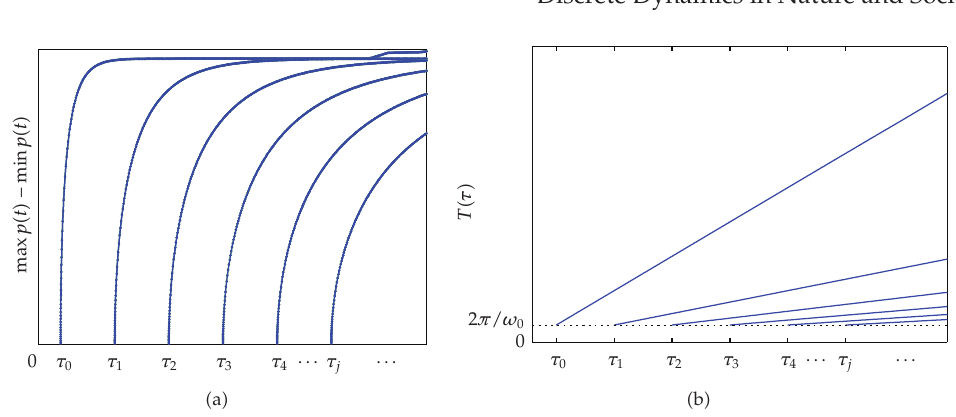
Figure 2: Hopf bifurcation branches through the centers (cid:4) v,τ j , 2 π/ω 0 (cid:5) . (cid:4) a (cid:5) on the (cid:4) τ,d (cid:5) -plane, where d (cid:8) max p (cid:4) t (cid:5) − min p (cid:4) t (cid:5) ; (cid:4) b (cid:5) on the (cid:4) τ,T (cid:4) τ (cid:5)(cid:5) -plane, where T (cid:4) τ (cid:5) is the period of periodic solution bifurcated at v